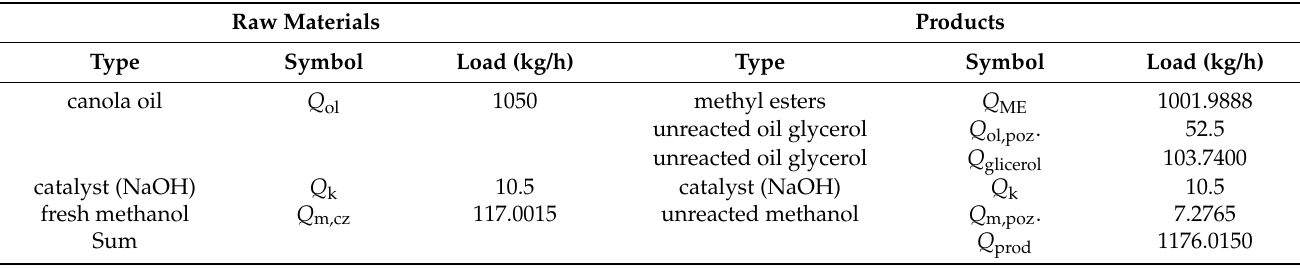
Table 2. Material balance of raw materials, products, and by-products after the stage of alcohol transesterification and recovery.